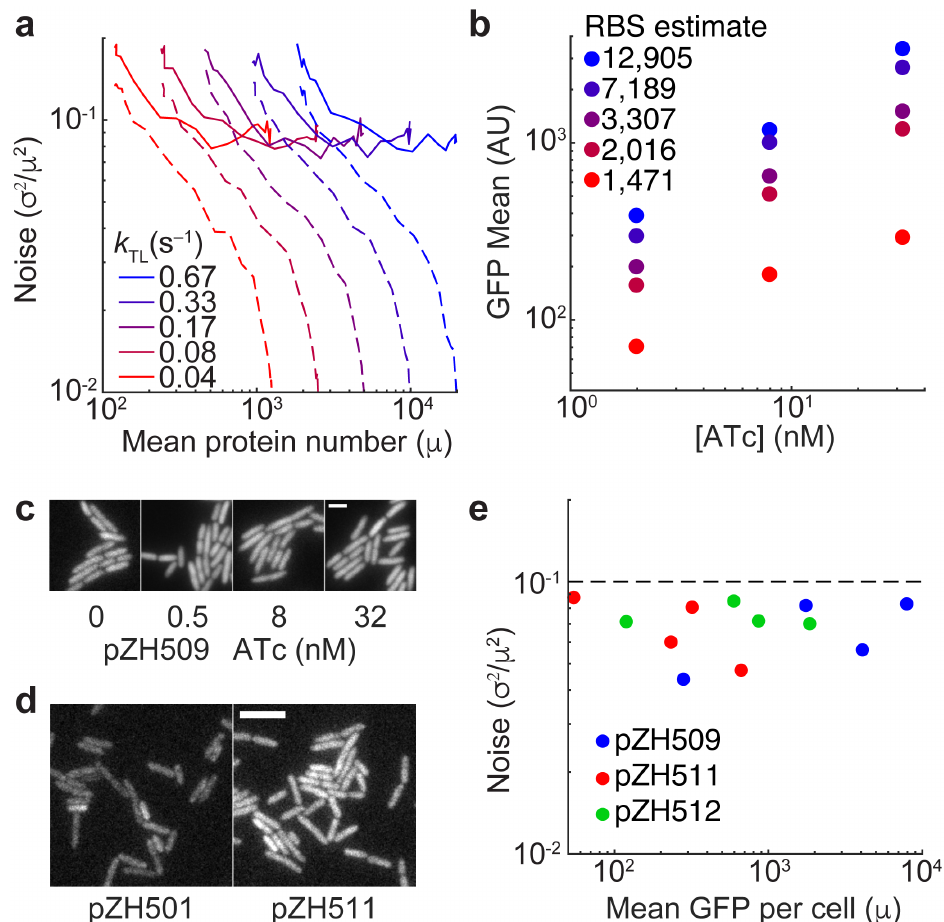
Fig 3. Induction dose-response and noise characterization for bicistronic autoregulation circuits with a range of expression levels. ( A ) Simulatedgene expressionmean and noise for the bicistronic, autoregulatory construct with different translation rates in the absence(dashedlines)and presence (solid lines) of extrinsic noise. ( B ) GFP expressionmeans for strains with mutated GFP ribosomebindingsites at various2, 8, and 32 nM ATc. Strains are colored by predicted ribosome bindingsite efficiencies.( C ) GFP expressionin unrelatedcells for the highest-expressionstrain pZH509 at 0, 0.5, 8 and 32 nM ATc. Maximum fluorescence intensities normalized by the mean numberof GFP moleculesper cell ( Table B in S1 Text). Scale bar 2 μ m. ( D ) Fluorescence of the non-GFP-expressingplasmidpZH501 is comparedto the lowest- expression-level plasmidpZH511 without induction. Intensity scalingidenticalfor both images. Scale bar 5 μ m. ( E ) GFP expressionmean (molecules/cell normalizedby cell area) and noise for plasmidspZH509, pZH511, and pZH512 at 0, 0.5, 8 and 32 nM ATc. Dashedline indicatesthe approximateglobalextrinsic noise limit